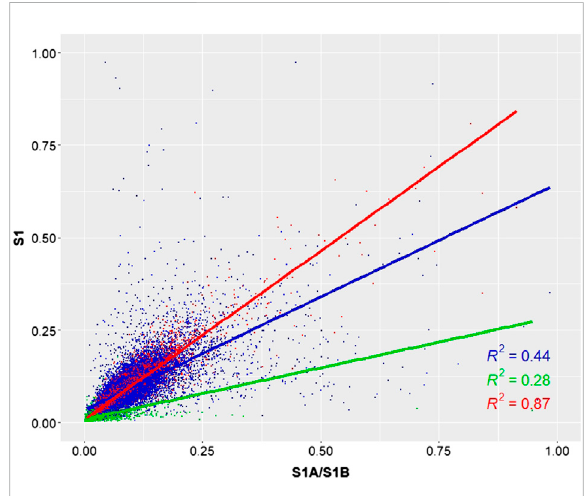
FIGURE 4 Scatter plot between the covariance matrix elements of the pseudo-polarimetric product ( y axis) and the dual-polarization inputs ( x axis). red: S1A_C11 vs. S1_C33 (VV); green: S1B_C22